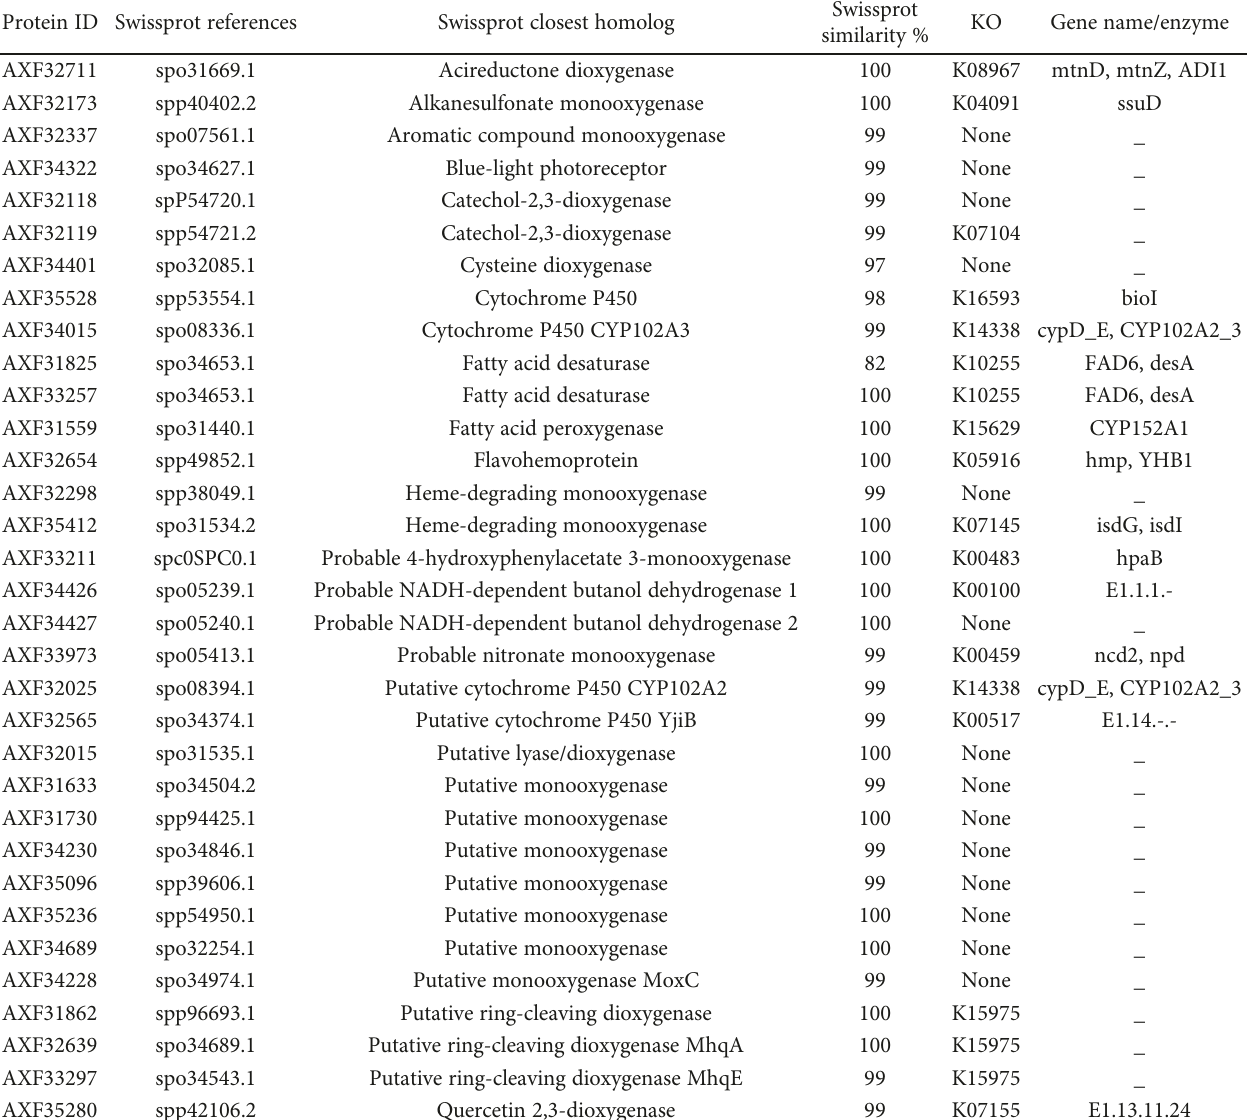
Table 5: List of proteins involve in degradation of petroleum compounds. Protein ID Swissprot